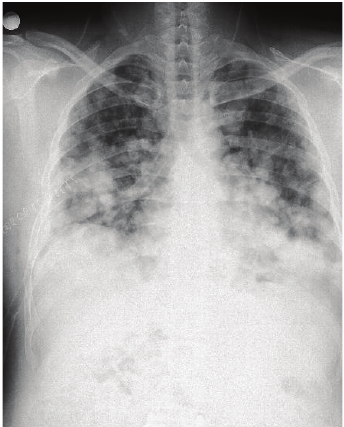
Figure 1: Nodular opacities varying in size present in all lung zones.